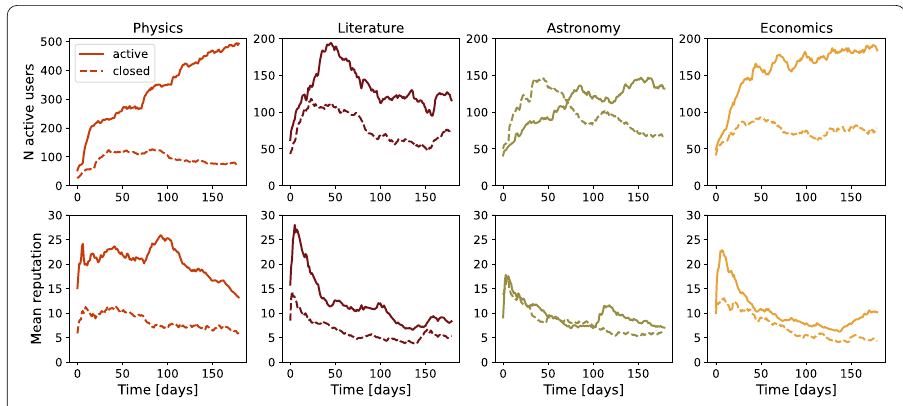
Figure 5 Active users within SE communities and their mean dynamic reputation. The number of active users (users with a reputation higher than 1) - top panel, and mean Dynamic Reputation within active users – bottom panel for the four pairs of Stack Exchange websites: Astronomy, Literature, Economics, and Physics. Solid lines – active sites; dashed lines - closed sites